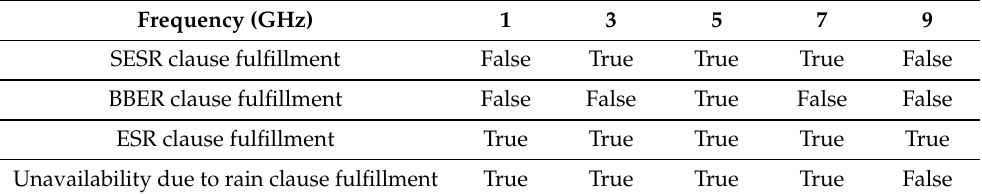
Table 5. Project clause fulfillment for the simulated terrestrial project.